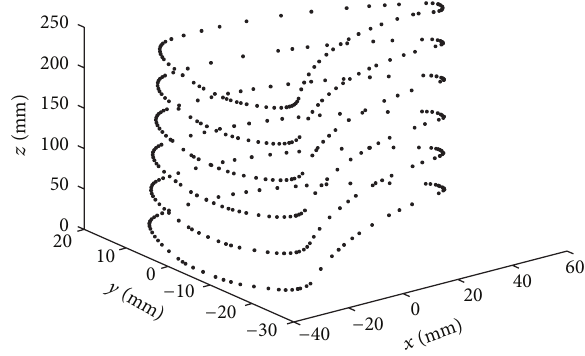
Figure 7: The less measured